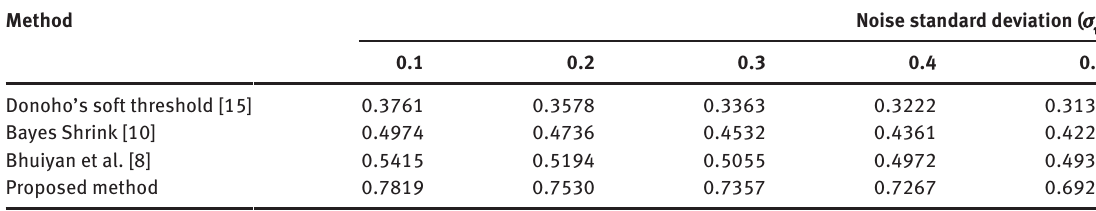
Table 4: Comparison of BC Performance for MR Images.